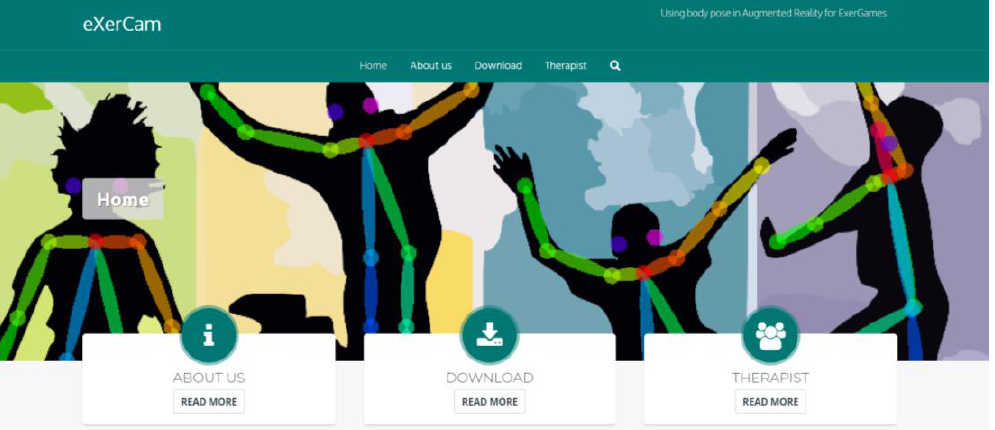
Figure 6. Web page of ExerCam. 356